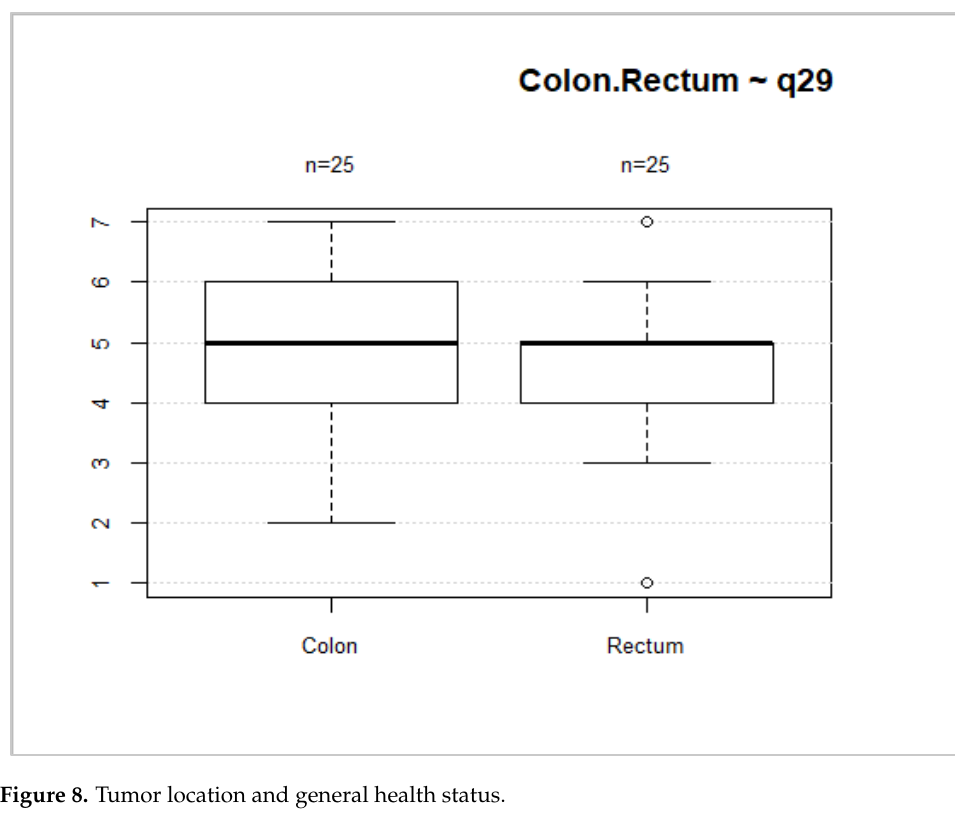
Figure 8. Tumor location and general health status.